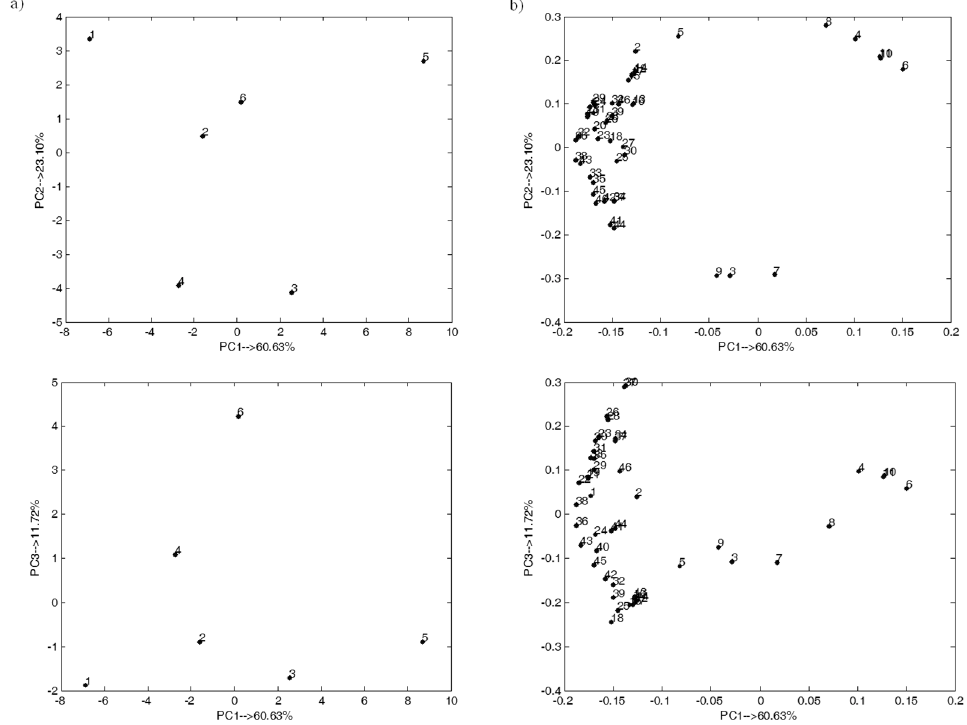
Figure 5. ( a ) Score plots and ( b ) loading plots of principal component analysis (PCA) for centered and standardized Xc dataset.